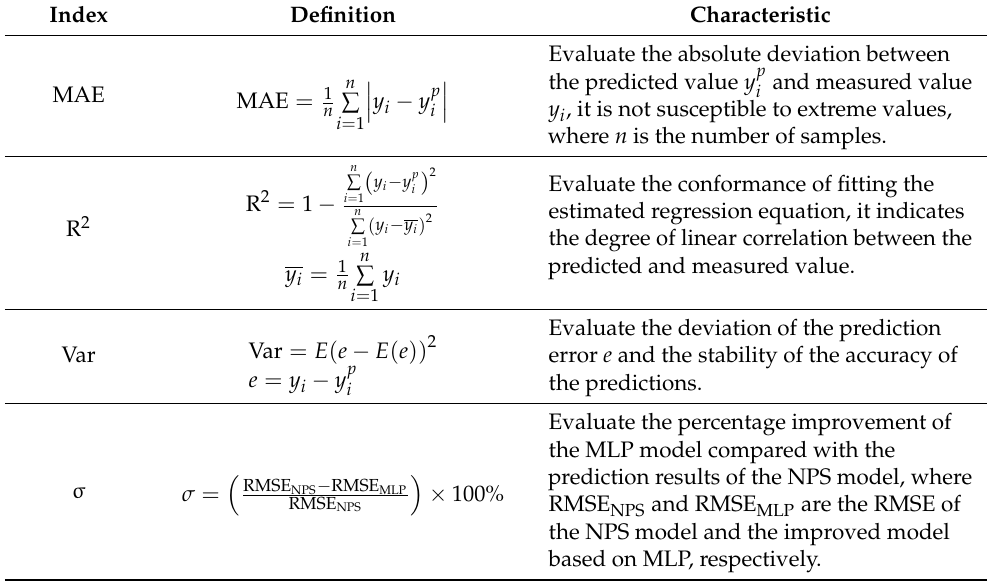
Table 4. Equation and characteristics of the performance